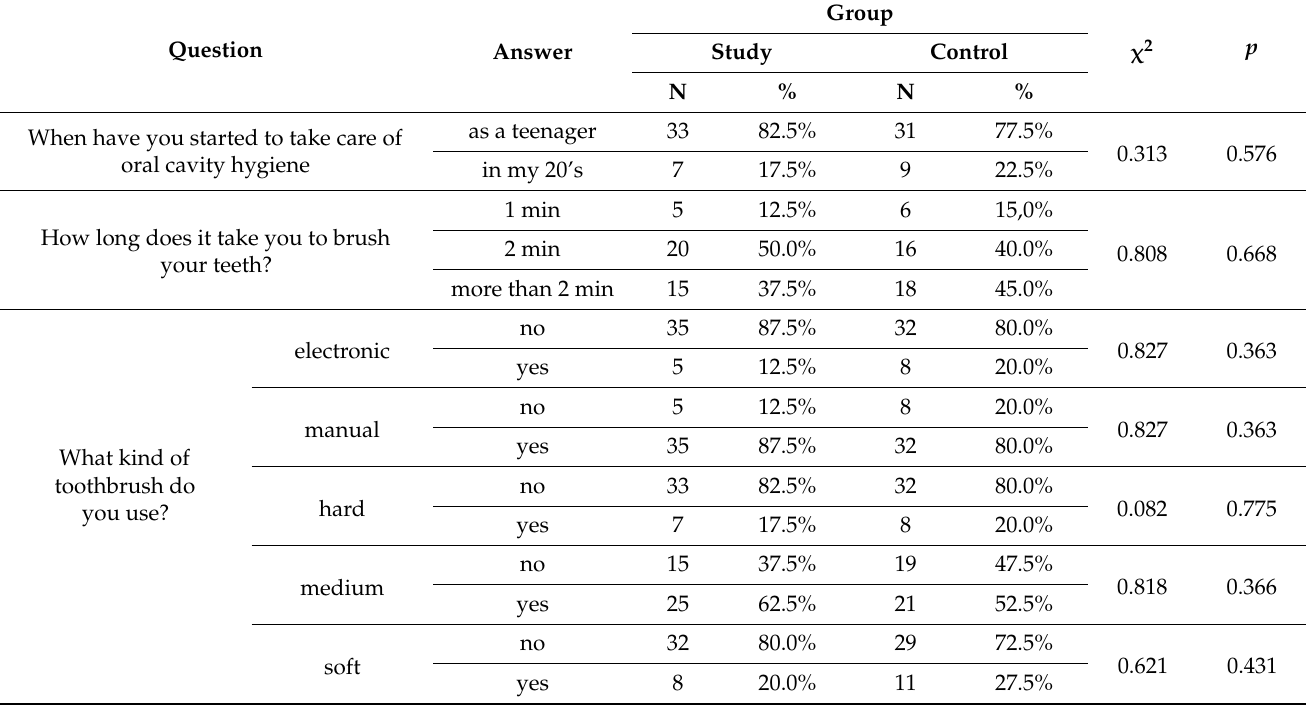
Table 1. Results of questionnaire analysis.